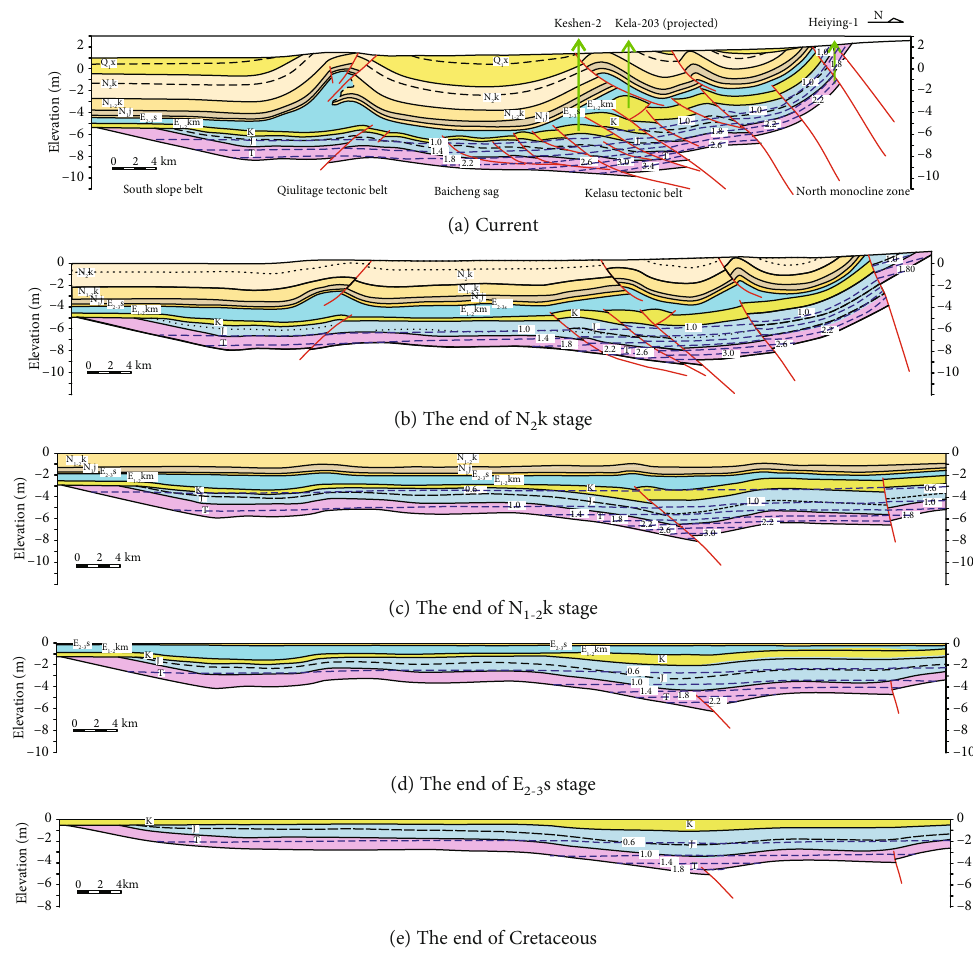
Figure 8: The structural and thermal evolution map of the geological section (the Keshen-2